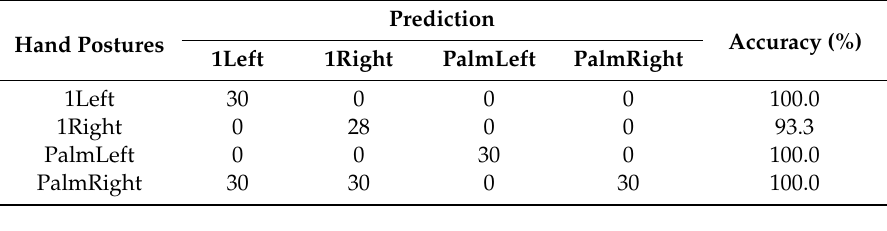
Table 15. A confusion matrix of deictic hand postures.